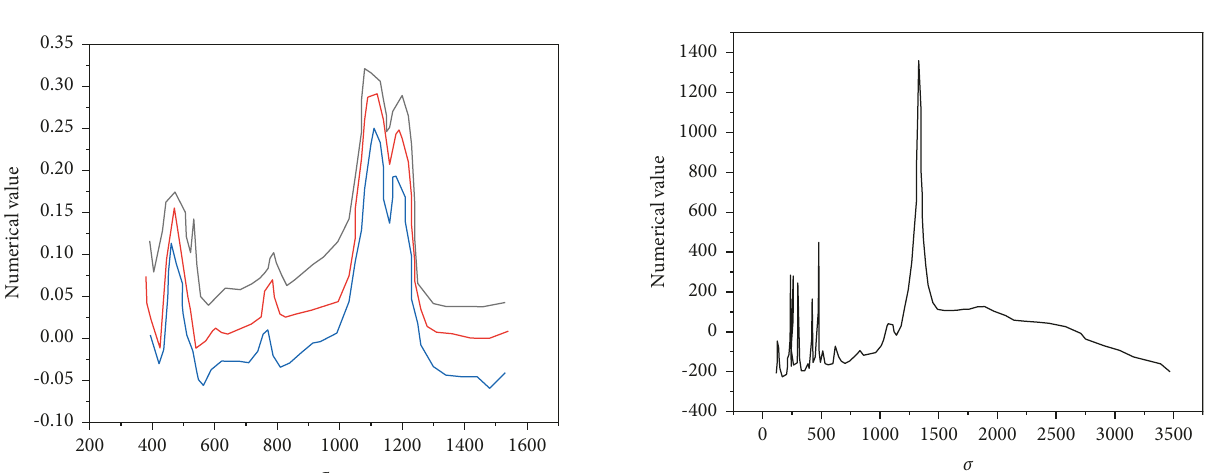
Figure 2: Comparison of infrared absorption spectra of south red